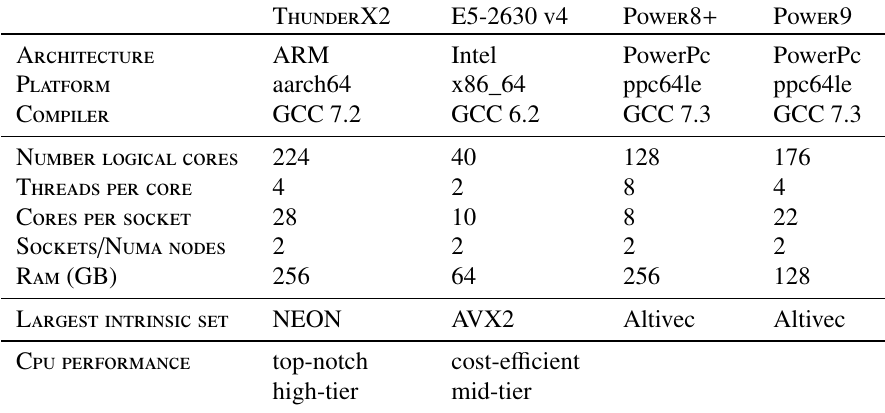
Table 2: Machines used for the benchmark T hunder X2 E5-2630 v 4 P ower 8 + P ower 9 A rchitecture ARM Intel